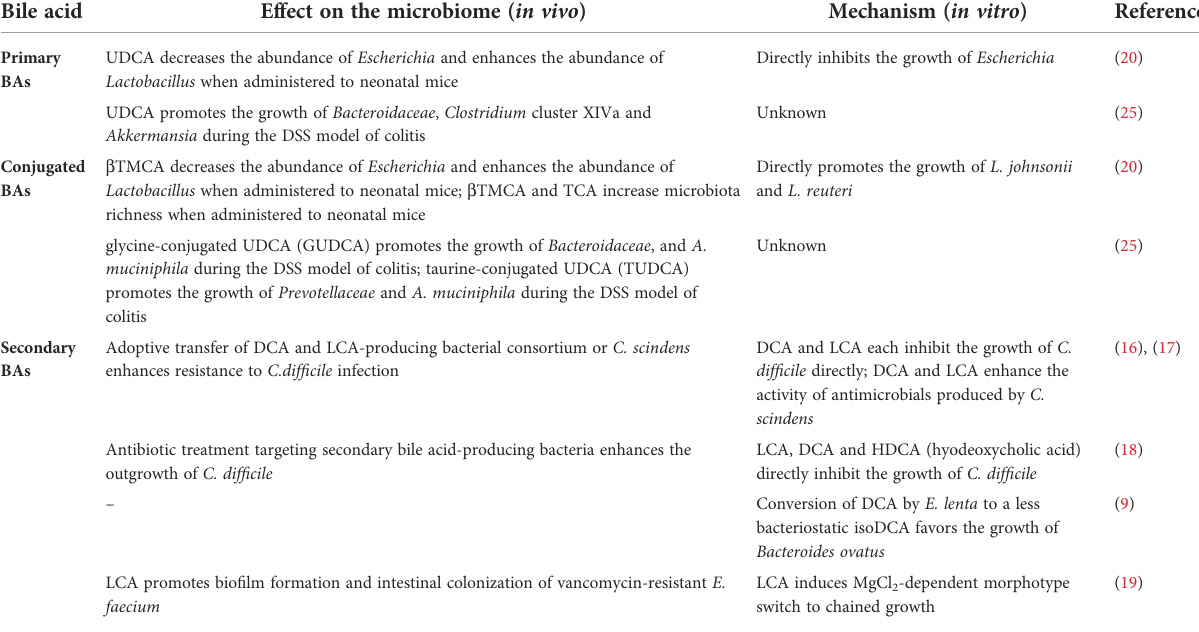
TABLE 1 The role of bile acids in shaping the microbiota composition. Bile acid Effect on the microbiome ( in vivo